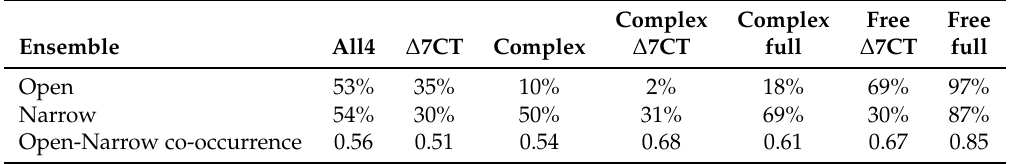
Table 2. Distribution of the conformers in the individual ensembles according to the principal components. The thresholds between open-closed and narrow-wide conformations are chosen to be 0 along the first and second PCs, respectively. The co-occurrence values provide a measure of how the different states appear simultaneously in the different